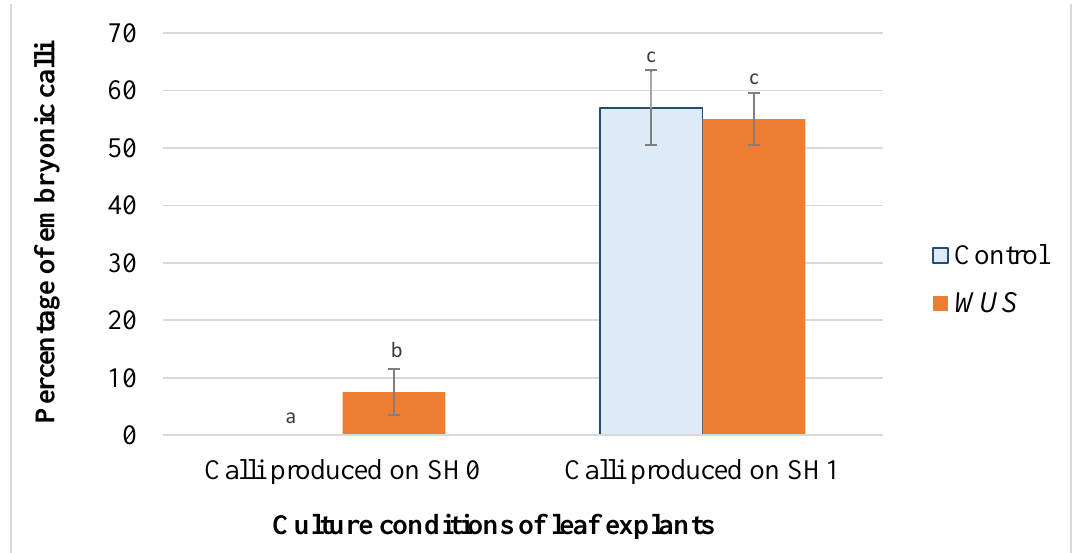
Figure 4. Embryogenic calli production from leaf explants of Medicago truncatula . Percentage of embryonic calli formed on leaf explants of M. truncatula transformed using pCambia- BAR (Control) and pCambia1301- WUS-BAR l ( WUS ) cultured on SH2 (without growth regulators). These calli were produced on SH0 (without growth regulators) or on SH1 (4 mg.L − 1 2,4-D, 0.5 mg.L − 1 BAP). For each condition, 60 root explants were cultured per replicate. Three replicates were performed for each condition. Bars with different letters were significantly different at p < 0.05.